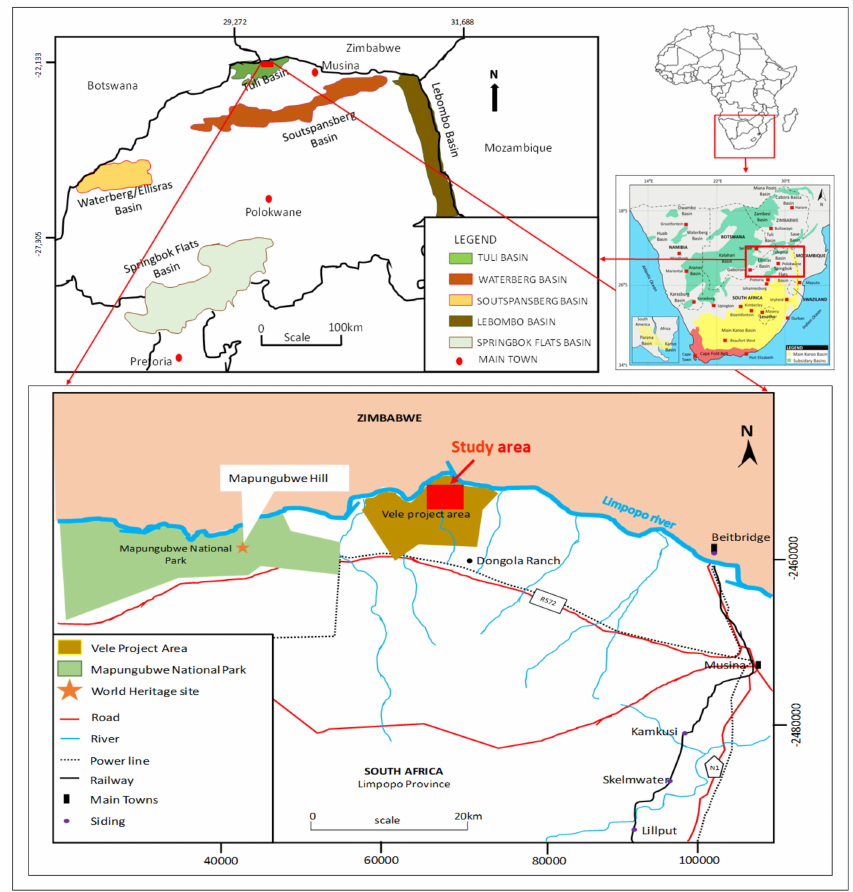
Figure 1. Map showing the Limpopo Karoo basins and location of the study area within the Vele Colliery (after